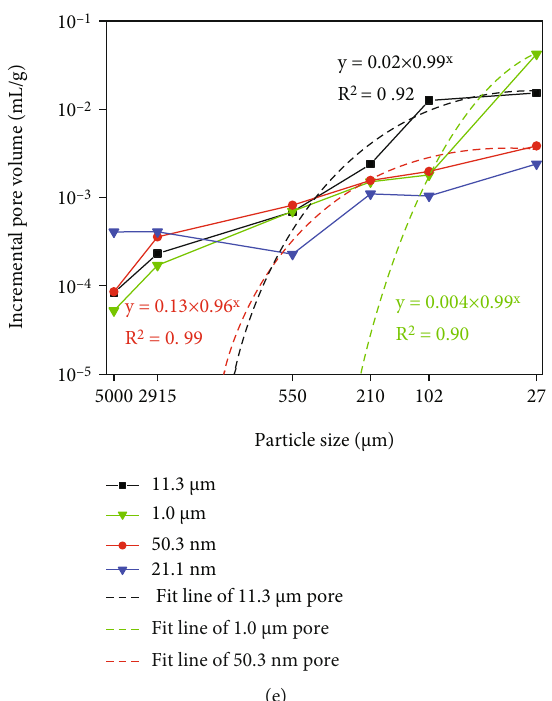
Figure 4: The incremental mercury intrusion volume of shale samples with di ff erent particle sizes: (a) complete curve; (b) pore size range of 20nm-10 μ m; (c) pore size range of 3-20nm; (d) the relationship between the incremental pore volume di ff erence with 5000 μ m particle size and pore diameter; (e) the relationship between incremental pore volume and shale particle